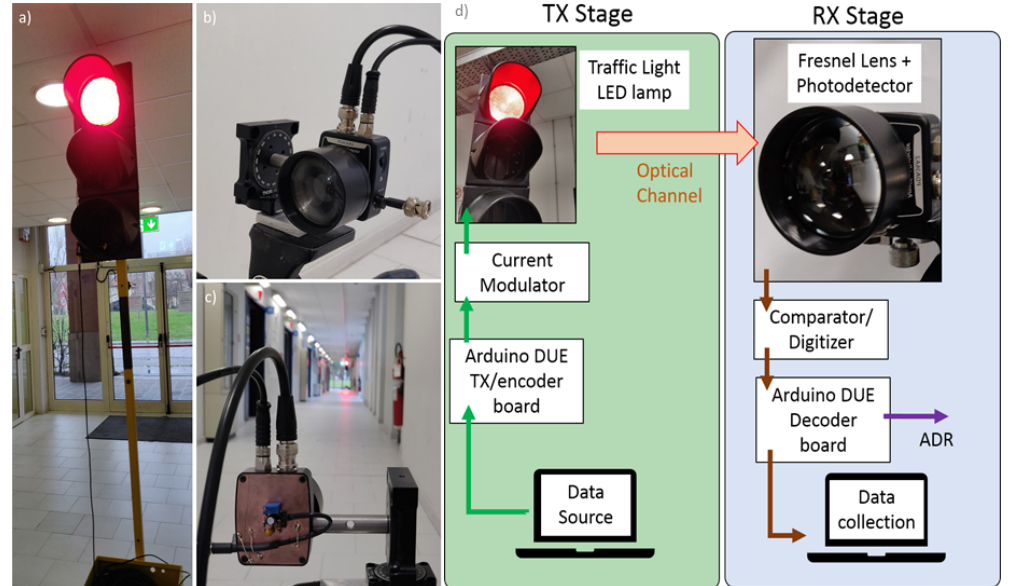
Figure 2. Experimental setup: ( a ) Transmitter unit: a standard traffic light that is used as a transmitter. ( b ) Receiver unit: photodetector, which consists of the Fresnel lens and an AC-coupled photodiode with a variable gain. ( c ) Receiver is positioned in front of traffic light and two system configurations, Optimal and Flat are used for performance analysis of the prototype. ( d ) Block diagram of the complete Visible Light Communication (VLC)